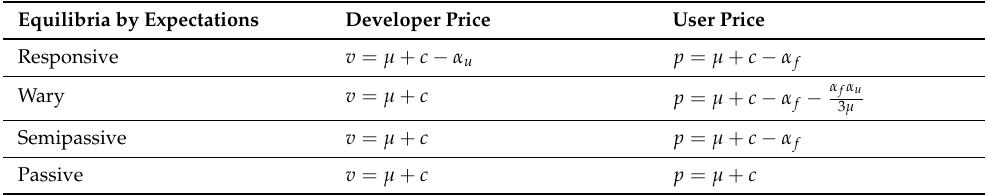
Table 2. Price equilibria for each information level. Source: Ref. [23] Equilibria by